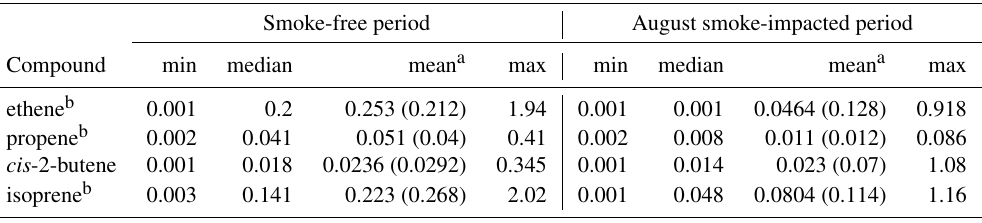
Table 1. Summary of alkene statistics at the Boulder Atmospheric Observatory during the smoke-free period and the August smoke-impacted period in summer